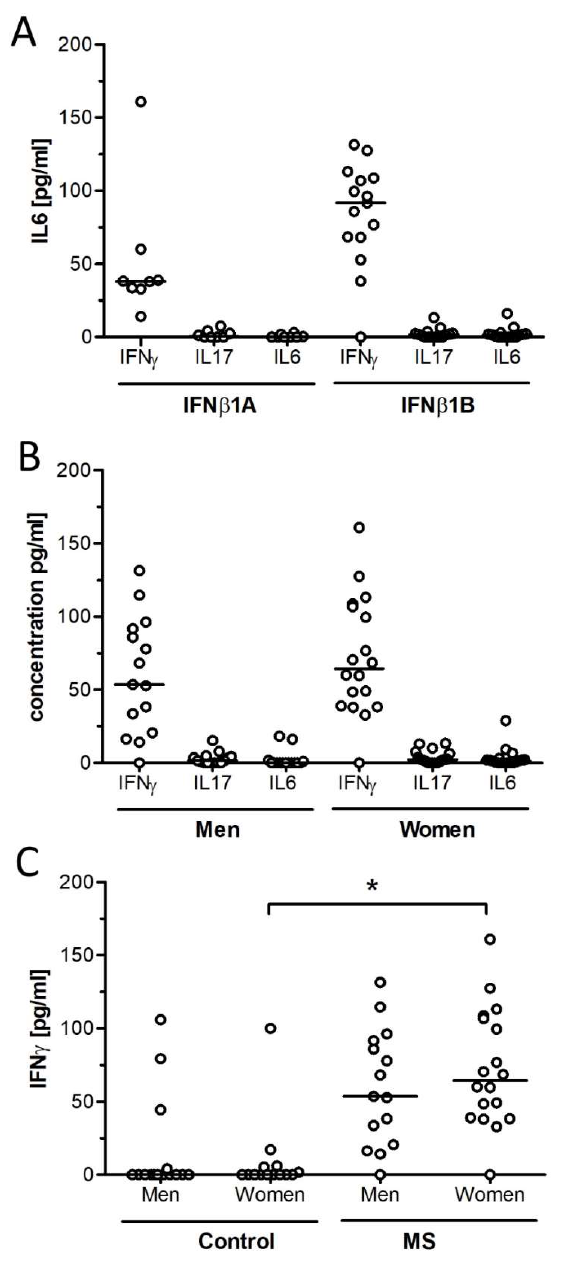
Figure 4. Cytokine concentrations in MS patients. Cytokines were determined using ELISA MAX Deluxe kits (BioLegend). The results show the values of all subjects belonging to each group. The line represents the median of each cytokine in pg / mL. Significant di ff erences were assessed using the Mann Whitney U test, (*) means p < 0.05. According to ( A ) IFN- β type: 1A and 1B. ( B ) Gender of MS patients. ( C ) Gender of the control and MS patients.